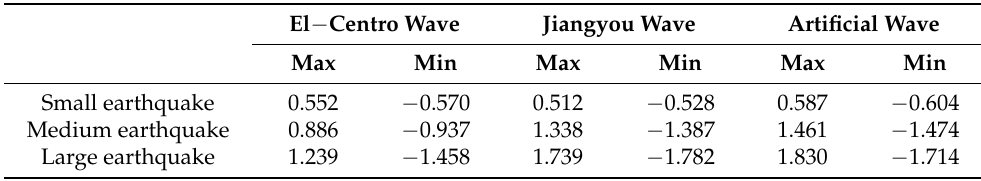
Table 4. The extremum acceleration of the top floor of the tower with control condition under 8-degree earthquakes (g).